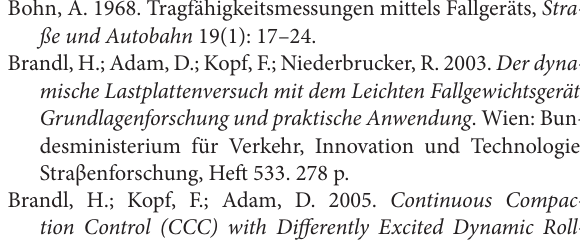
Fig. 7. Dependence for laboratory tests